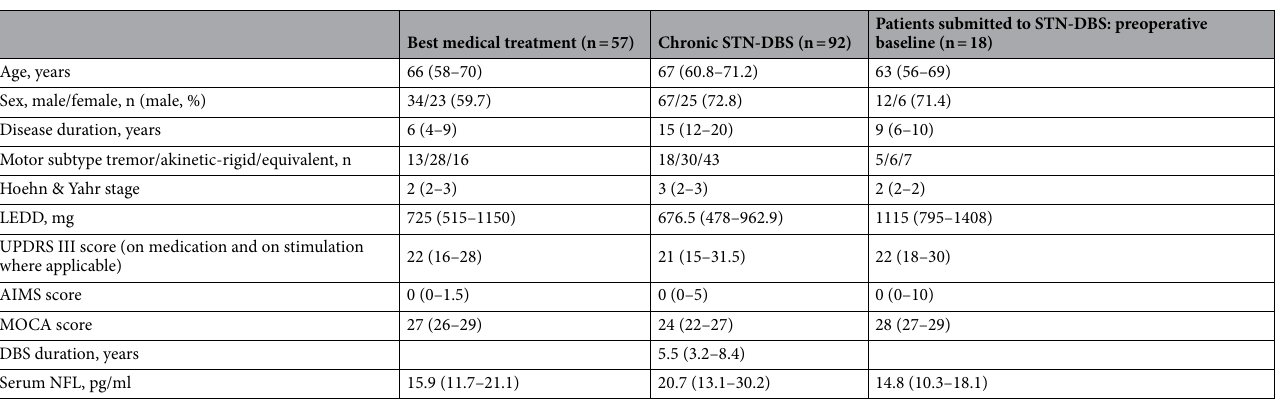
Table 1. Demographic and clinical data. Data are median (Q1: lower quartile—Q3: upper quartile) except for sex and motor subtype (n). LEDD levodopa equivalent daily dose, UPDRS III Unified Parkinson’s Disease